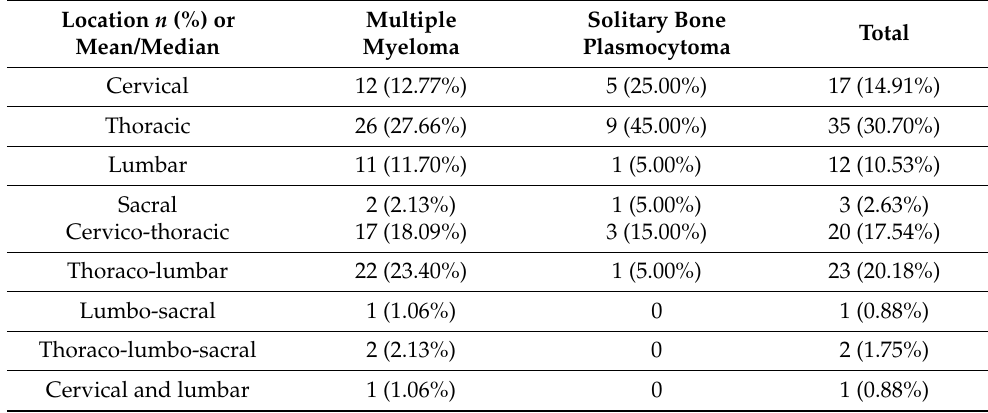
Table 2. Localization of tumor